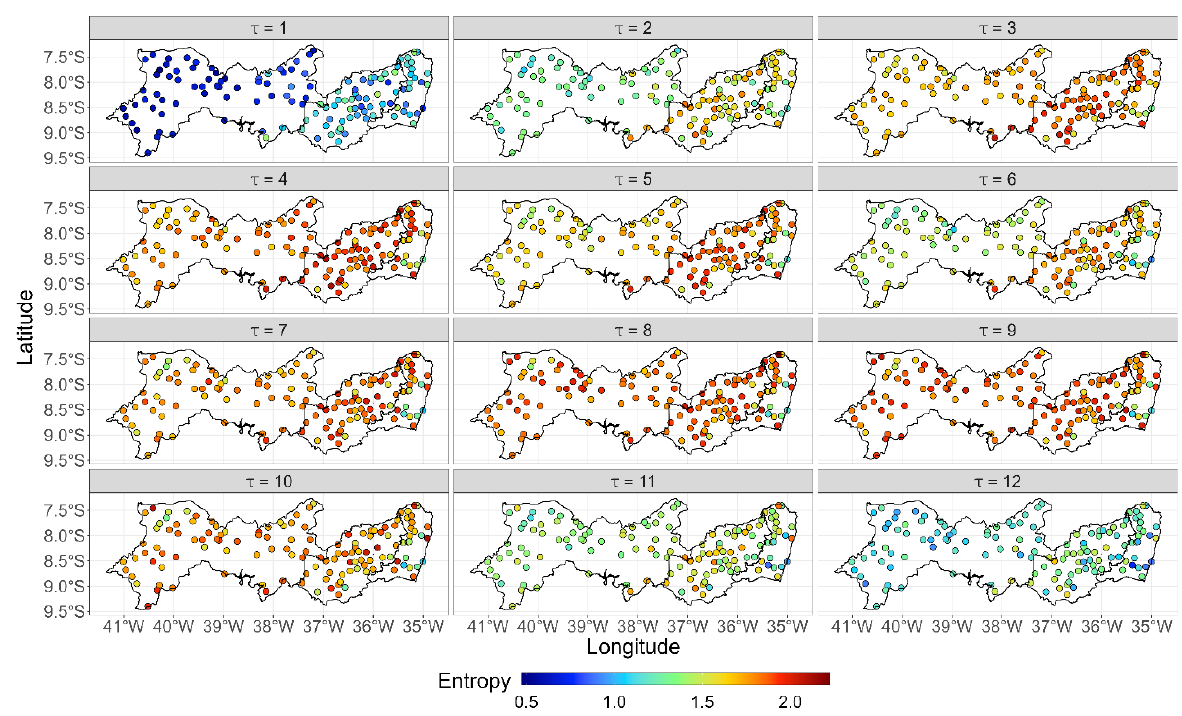
Figure 5. Spatial distribution of MMSE ( τ = 1, 2, …, 12 months) over the state of Pernambuco for rainfall original series.